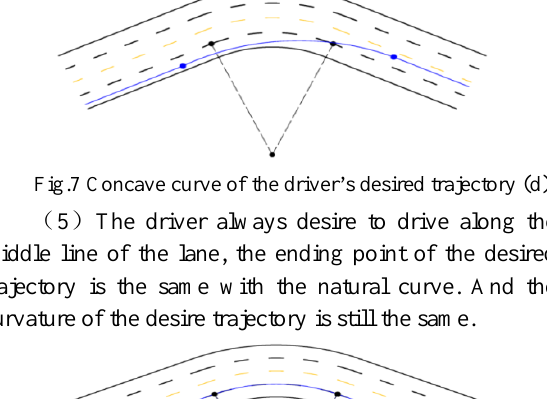
Fig.6 Concave curve of the driver’s desired trajectory (c) （ 4 ） Drivers desire to drive along the lane outside the center line when they derived to the curve, and desire to drive the lane inside the center line when they leave the curve, there is a interaction between the uncertain position of the middle curve and the center line of the lane. Desired trajectory’s starting point is advanced, and the ending point is left behind. And the curvature is reduced.